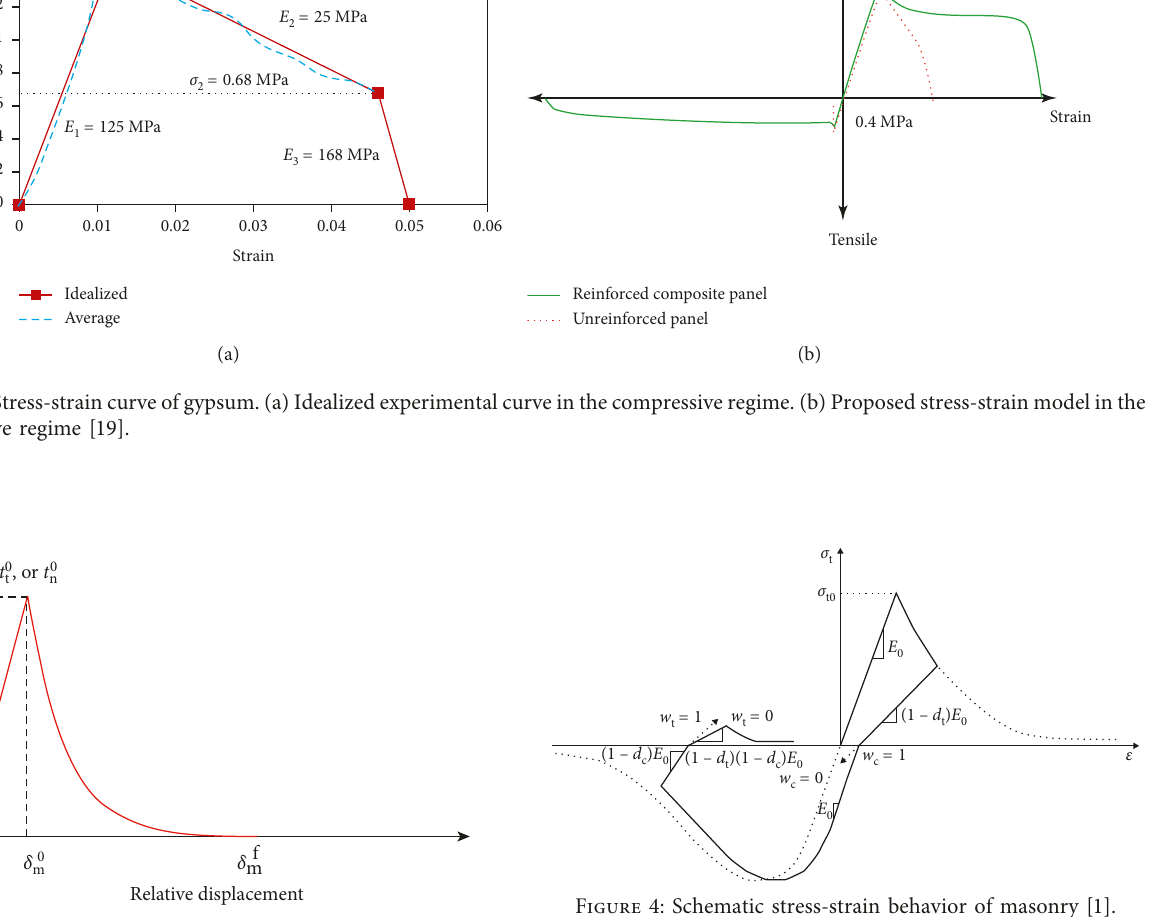
Figure 3: Mortar’s damage (tensile and shear) evolution mecha- nism [1].